Question: Which kind of chart has been used to present this data?
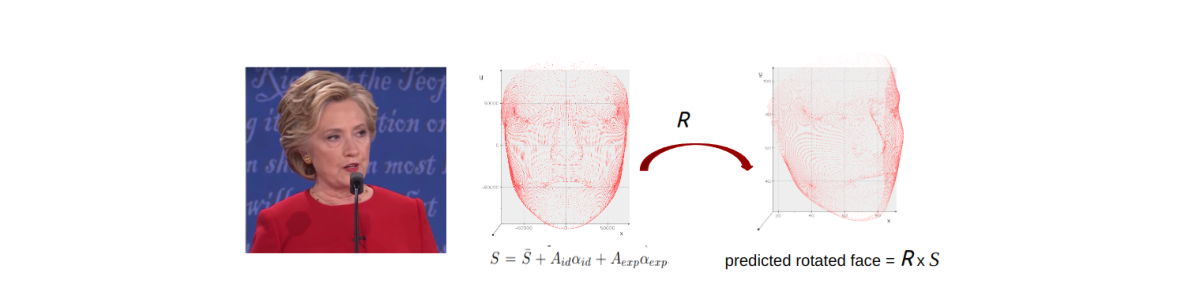
Answer: line